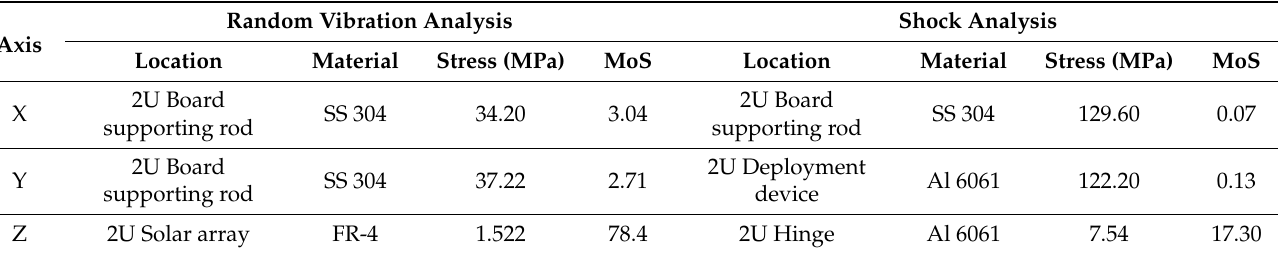
Figure 8. Random vibration and shock analysis results: ( a ) random vibration (maximum stress in Y-axis); ( b ) shock (maximum stress in X-axis). Table 3. Maximum stress of random vibration and shock